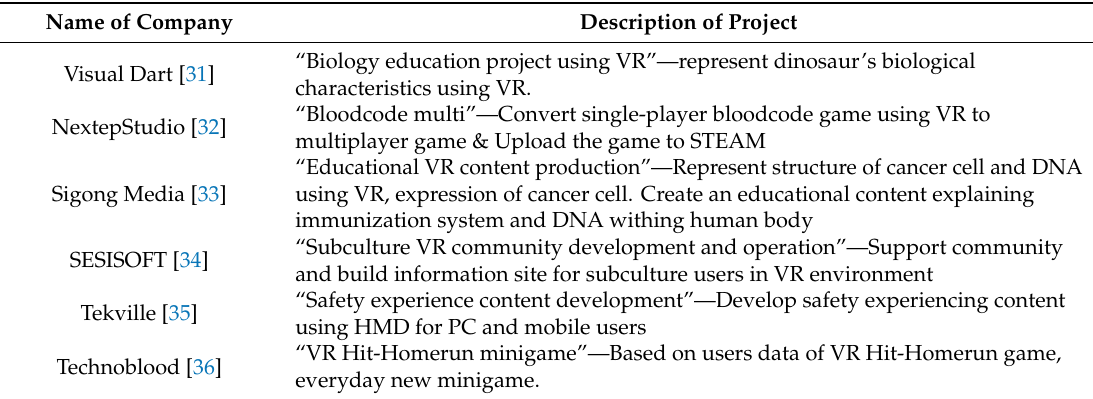
Table 5. Industrial project fulfilment step—Project